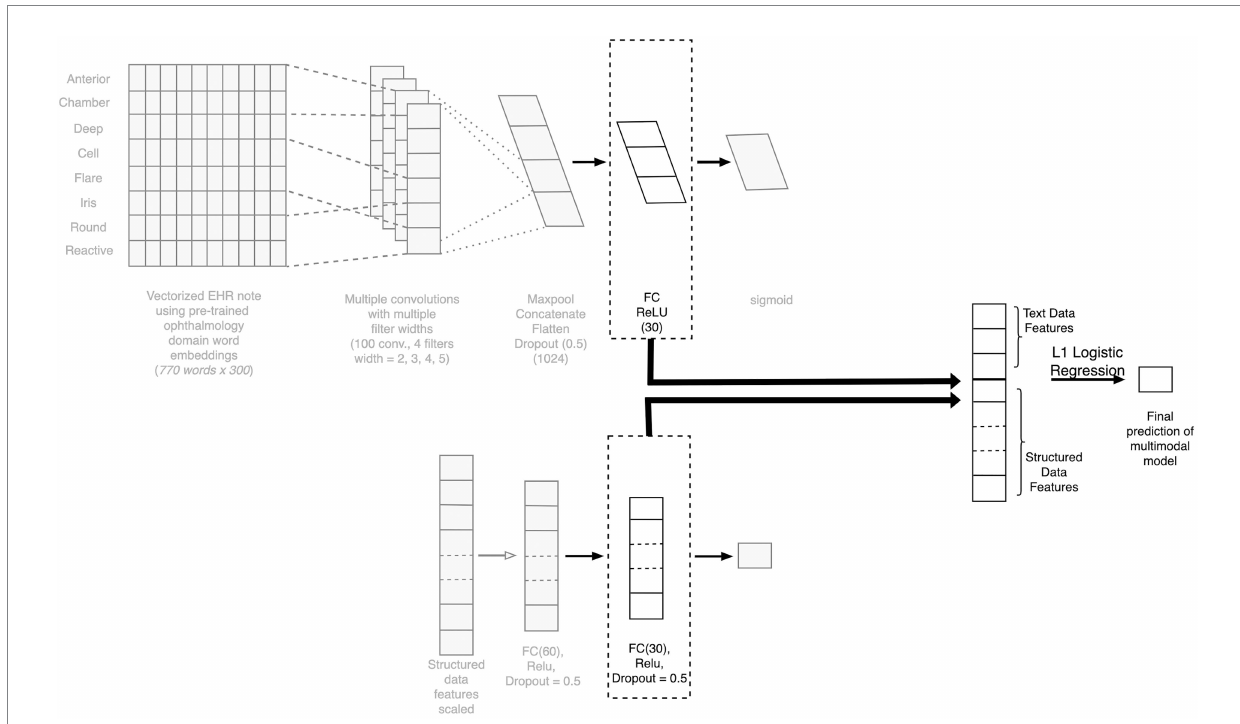
FIGURE 4 Architecture of the fusion model combining text and structured data. Depiction of the architecture of our multimodal fusion model, which fuses both structured and free-text modalities of data. The final layers of the TextCNN is concatenated with the final layer of the structured model neural network to create a combined feature vector for final prediction. CNN, competitive neural network; EHR, electronic health record; FC, fully connected.